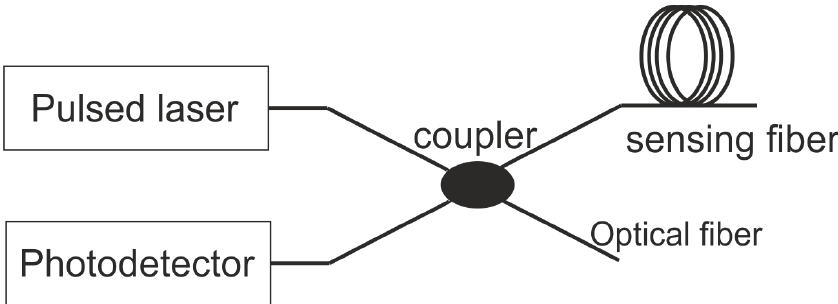
Figure 2. Schematic of φ OTDR (based on reference [21])